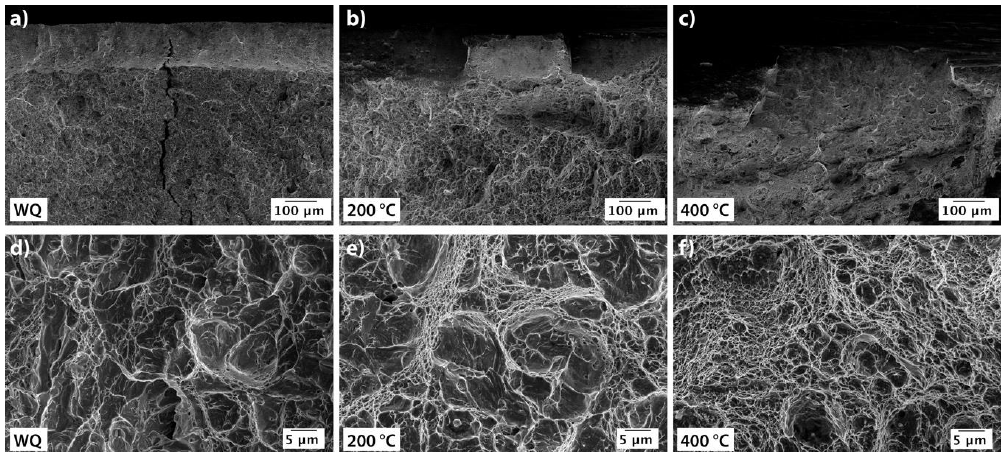
Figure 9. FESEM images of fracture surfaces taken from the upper part ( a ) water quenched, ( b ) tempered at 200 °C, ( c ) tempered at 400 °C and the middle part ( d ) water quenched, ( e ) tempered at 200 °C, ( f ) tempered at 400 °C of selected impact toughness samples tested at +20 °C.